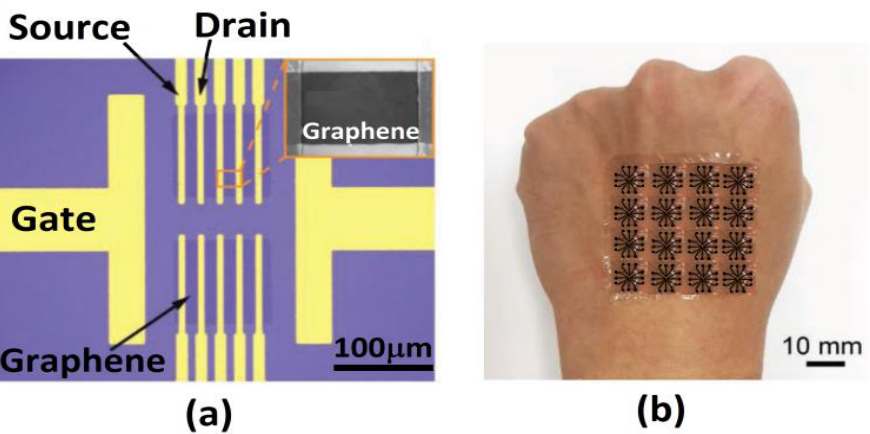
Figure 6. ( a ) Image of aptamer-based graphene nanosensor with on-chip source, drain and gate electrodes. Inset shows SEM image of electrodes on the graphene conducting channel. ( b ) Photographs of the sensor mounted on human hand. Reprinted/adapted with permission from [65], Copyright 2019, John Wiley and Sons-Books.